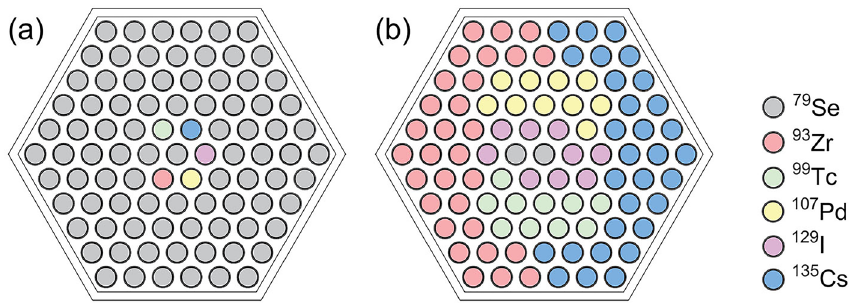
Figure 5. The distribution pattern of pins in LLFPs assembly for the maximum loading of 79 Se ( a ) and the optimal LLFPs scheme used to balance the transmutation efficiencies of all the LLFPs ( b ).